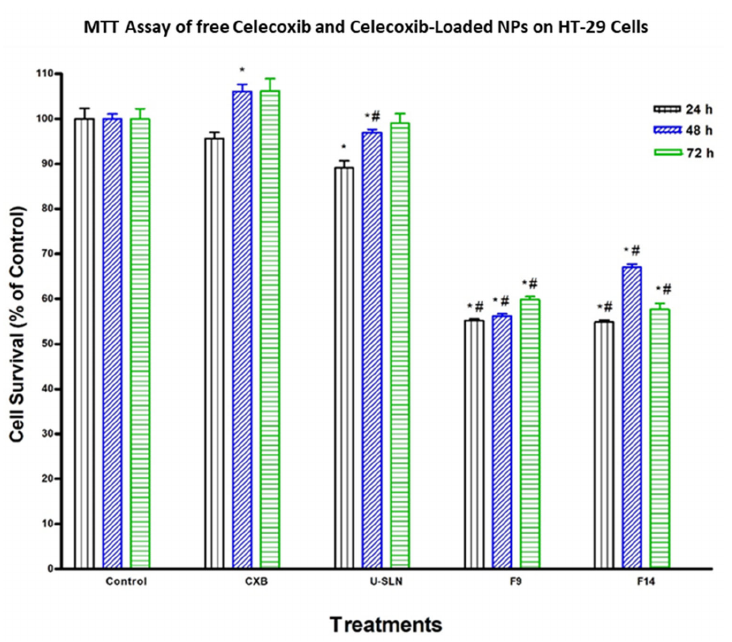
Figure 6. Effect of CXB and CXP–SLN on colorectal cancer cells. HT-29 cells were treated with indicated formulas of CXB–SLN (F9, F14), unloaded SLN (U-SLN), pure CXB or buffer (control) for 24, 48 or 72 h. Cell viability was determined by MTT assay, as indicated in Section 2. At the end of the assay, the absorbance at 549 nm was read on a microplate reader. Significant differences between treatments and control and CXB were analyzed by ANOVA followed by t ‐ test. * p < 0.05 compared with control (0 μ M). # p < 0.05 compared with CXB.